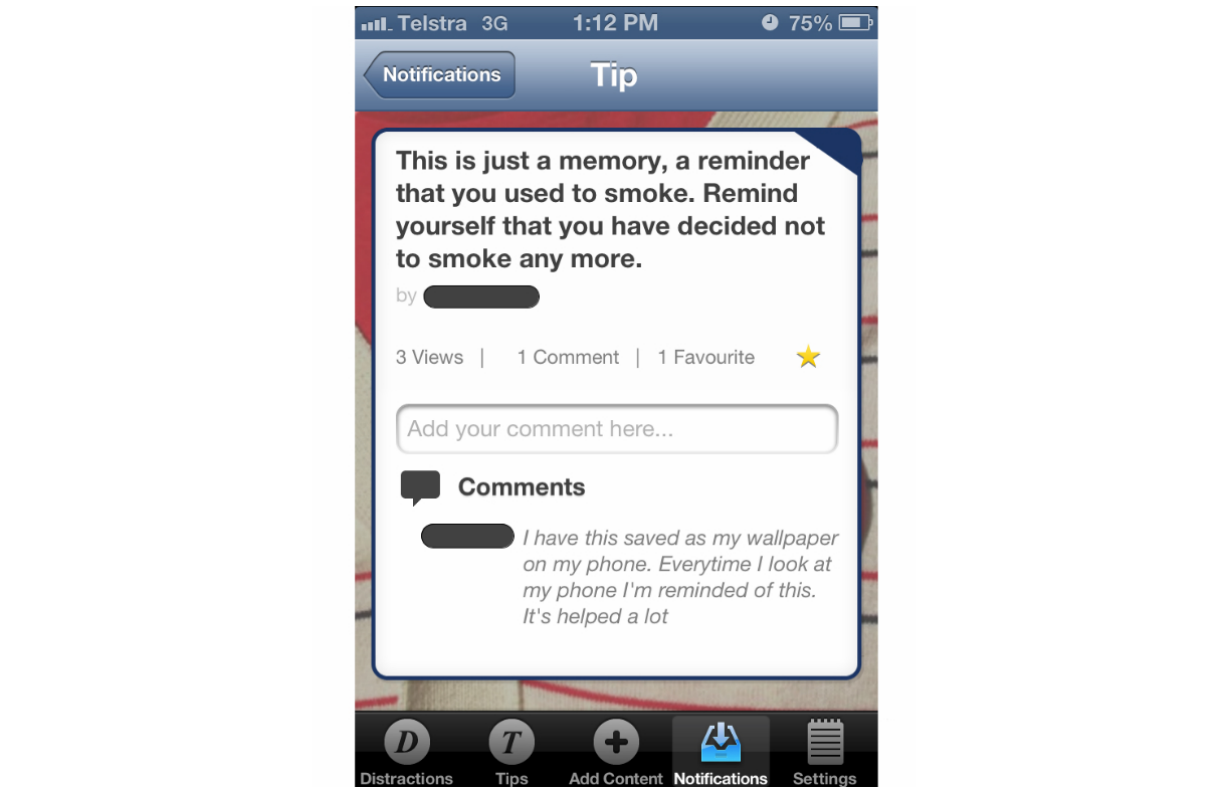
Figure 5. Participant 11 commented that she used this tip as a reminder to remain a nonsmoker as wallpaper on her